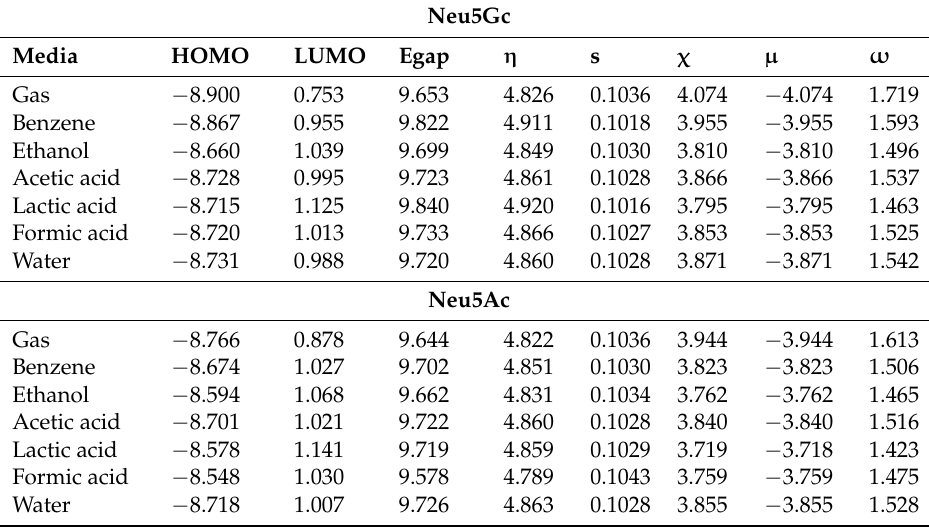
Table 2. Global reactivity index of Neu5Gc and Neu5Ac (at the M062X/6-311G(d,p) level, Egap: EHOMO-ELUMO, χ : electronegativity, µ : chemical potential, ω : electrophilic index, η : chemical hardness, s: chemical softness, unit: